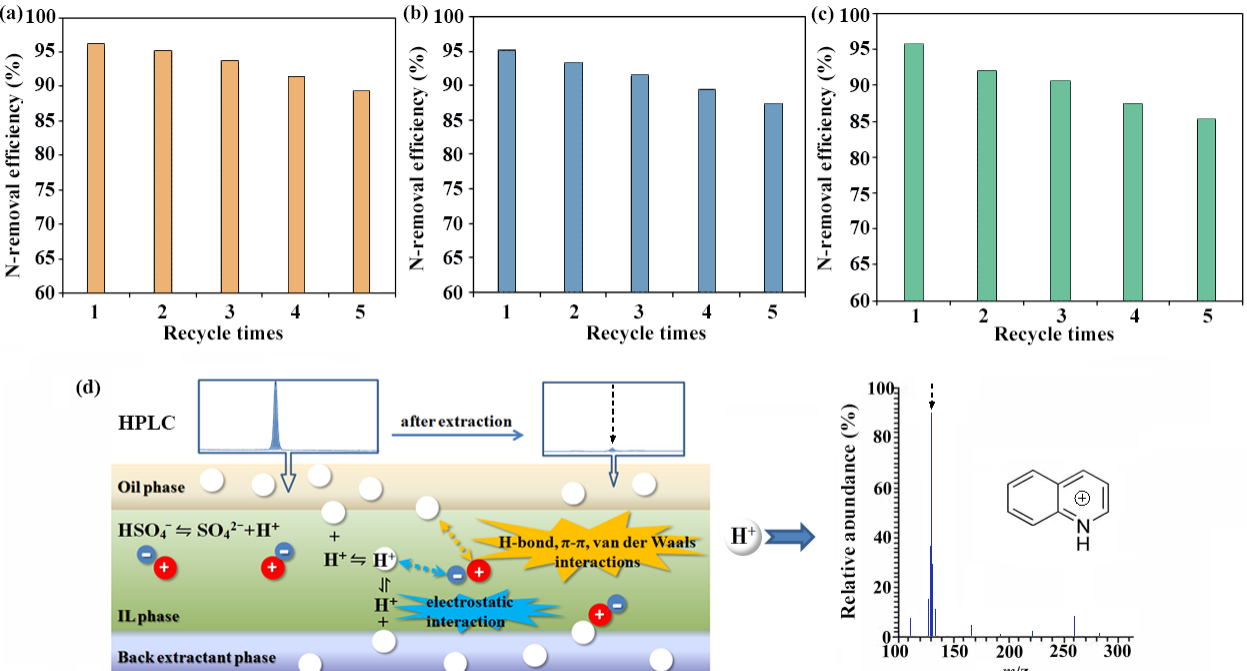
Figure 8. N-removal efficiency of the best IL in different recycle times for ( a ) pyridine, ( b ) quinoline, ( c ) aniline; ( d ) extraction mechanism in this study (white balls: targets, blue balls: IL anions, red balls: IL cations) under HPLC and MS analysis.